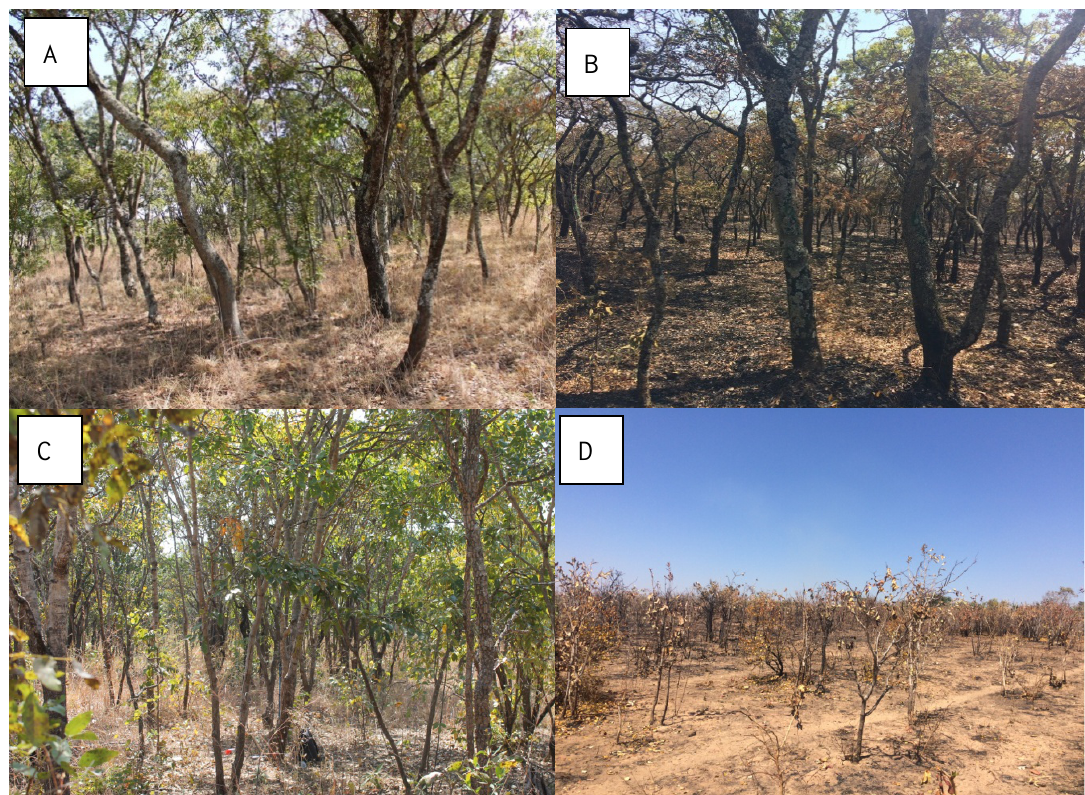
Figure A1. ( A ) Closed miombo before fire; ( B ) Closed miombo after fire; ( C ) Regeneration in opened miombo; ( D ) Grassland after fire